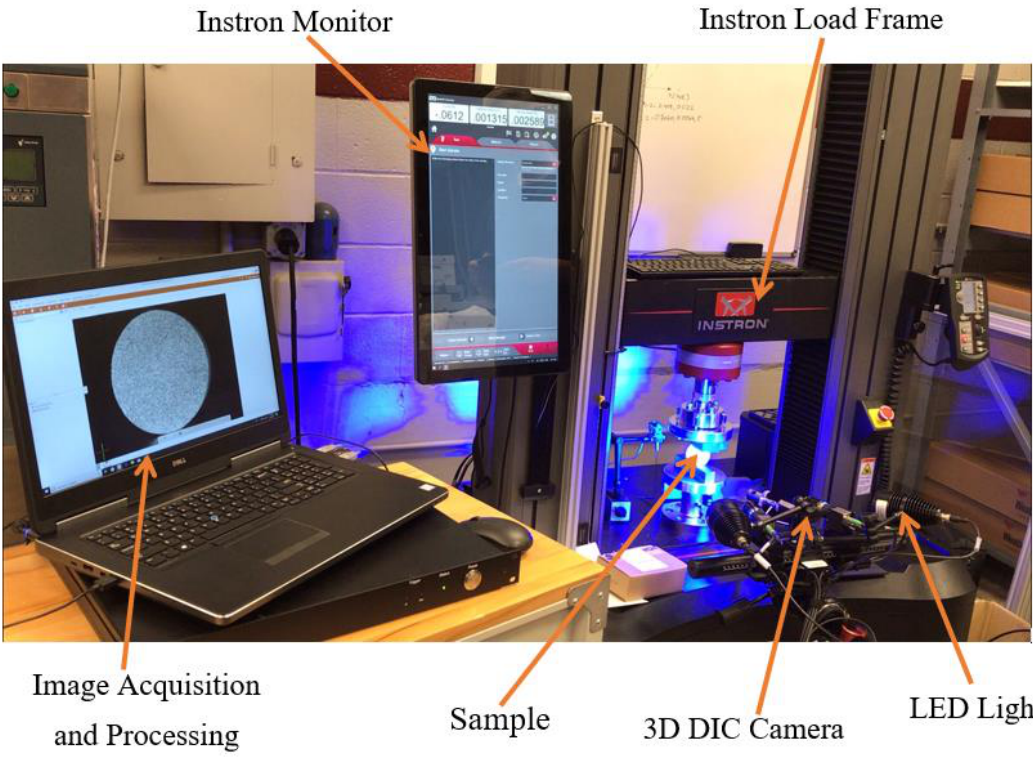
Figure 3. Diametrical compression testing with 3D DIC.